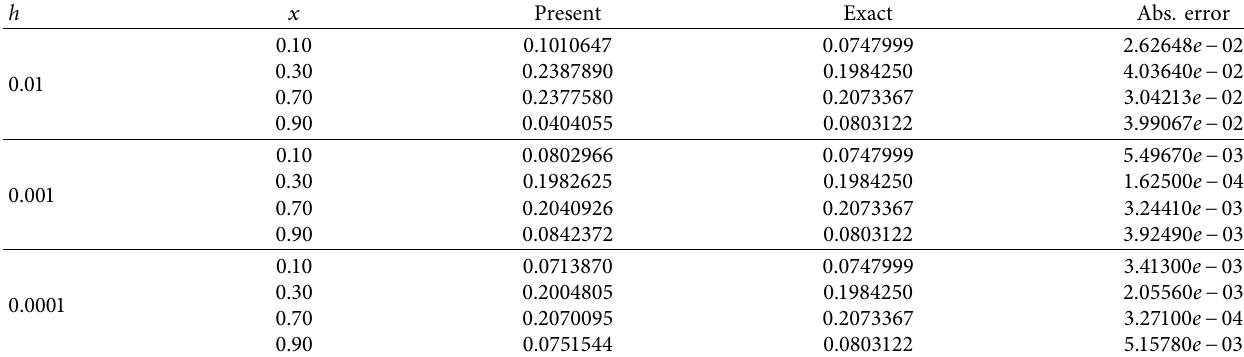
Table 5: Approximate solutions and absolute errors of Example 3 at T � 0 . 1, for values of ] � 1 and α � 0 . 9. h